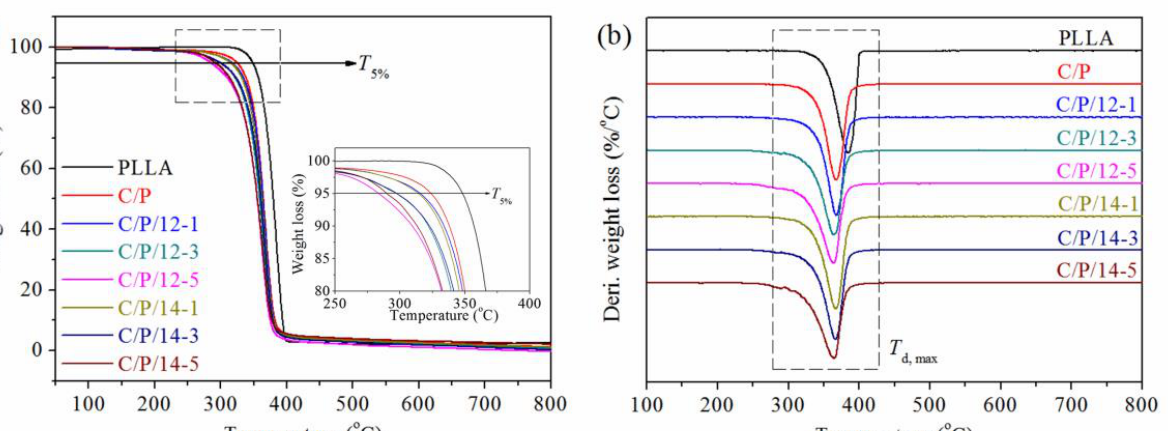
Figure 7. Static water contact angles of cellulose, PLLA, C/P, the compatibilizers, and the composites C/P/12-5 and C/P/14-5. 4. Conclusions In summary, this study proposed a simple and effective method to prepare a cellu- lose – PLLA composite with enhanced impact properties. Due to the good miscibility of the